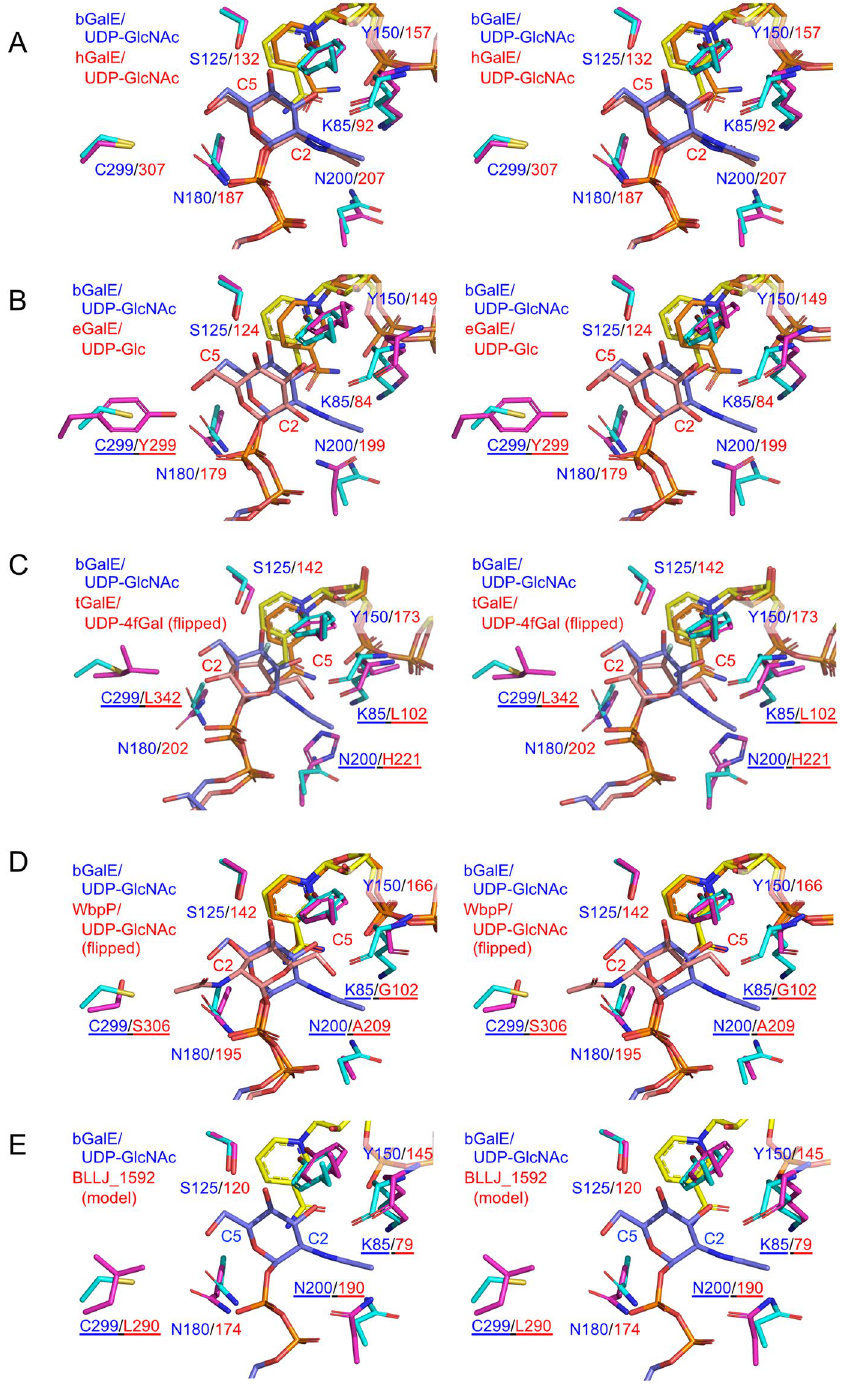
Figure 6. Stereoview of the UDP-sugar binding site in GalEs. Superimposition of bGalE + UDP-GlcNAc (cyan, blue, and yellow for protein, UDP-sugar, and NAD + ) and other GalE enzymes (magenta, pink, and orange for protein, UDP-sugar, and NAD + ) are shown. ( A ) hGalE + UDP-GlcNAc (PDB ID: 1HZJ chain B), ( B ) eGalE + UDP-Glc (PDB ID: 1XEL), ( C ) tGalE + UDP-4fGal (PDB ID: 2CNB chain A), ( D ) WbpP + UDP- GlcNAc (PDB ID: 1SB8), and ( E ) a homology model of